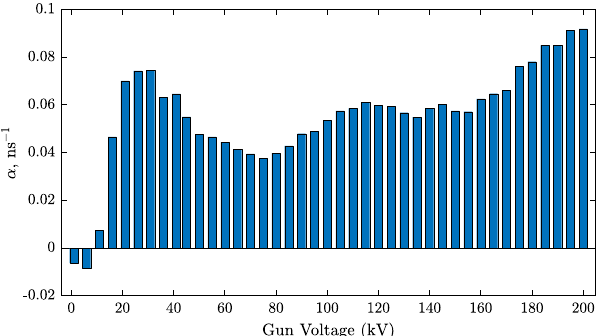
field.FIG. function of accelerating voltage in the SRF gun simulated by CST